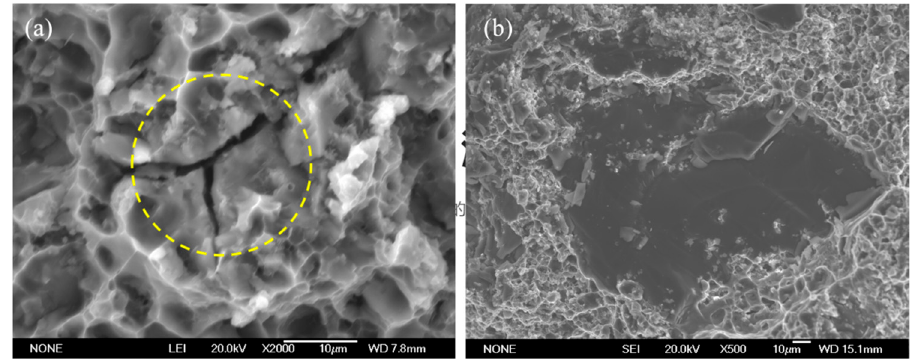
Figure 9. SEM images of the fracture surface of in situ SiCp-reinforced AMCs: ( a ) SEM image of Al-20Si-5C(G1) and ( b ) SEM image of Al-28Si-7C(G1).